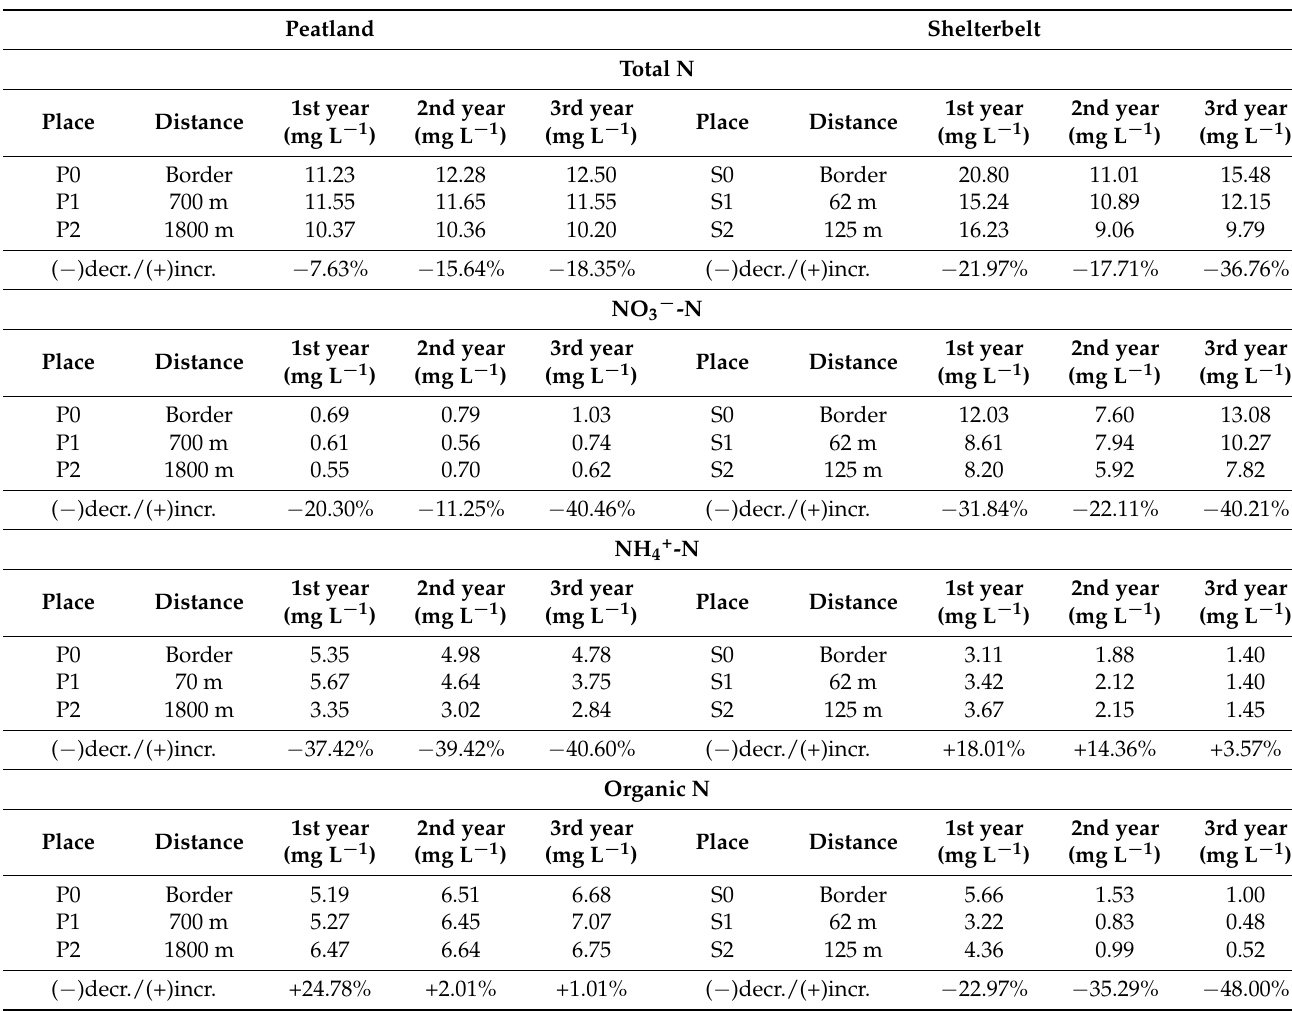
Table 6. Mean concentrations of total N, NO 3 − -N, NH 4+ -N and organic N in groundwater under peatland and shelterbelt soil. Peatland Shelterbelt Total N